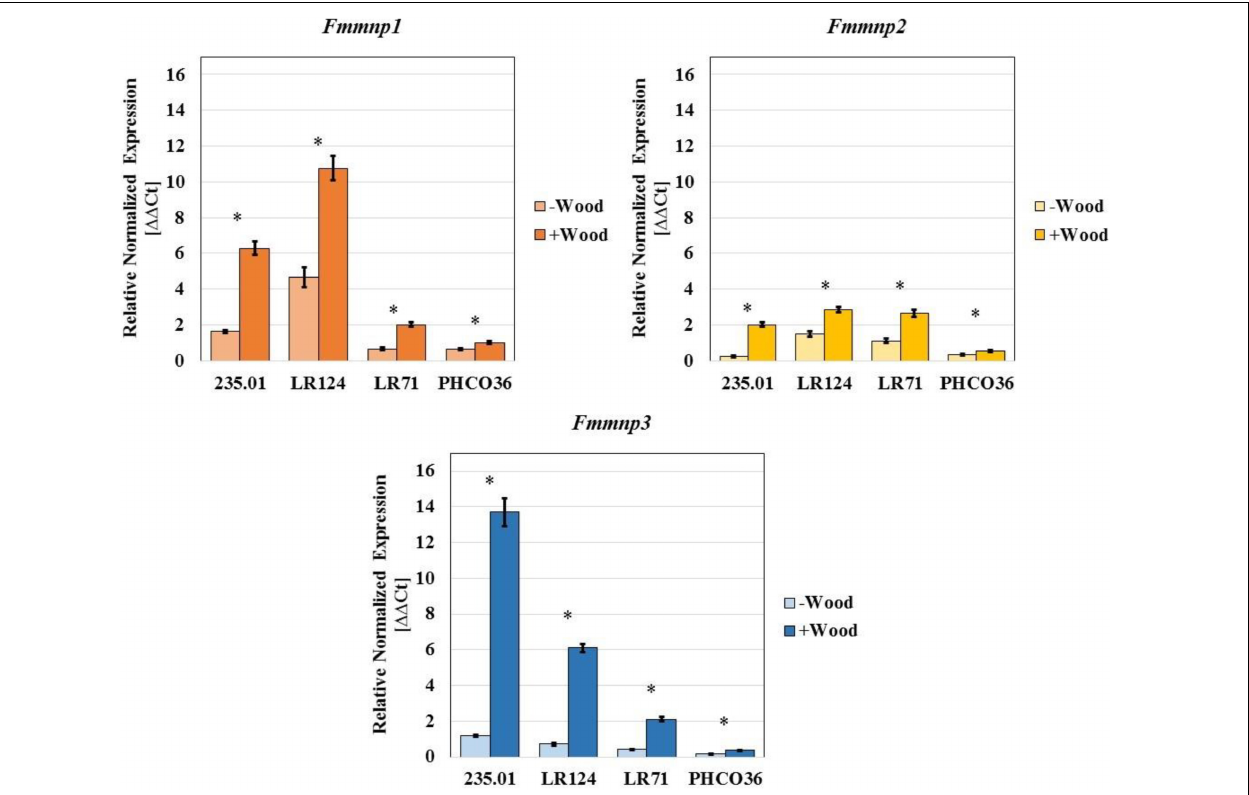
FIGURE 10 | Gene expression of three manganese peroxidase isoforms measured in 4 different strains of Fmed. Data are expressed as relative normalized expression of genes with cv. Gewurztraminer wood sawdust (+ Wood) and without sawdust (–Wood) compared to the mean of (cid:49) CT of samples grown without wood sawdust. The asterisk denotes significant difference in Student’s t -test with p ≤ 0.05 between gene expression with and without wood sawdust. Error bars on histograms represent the standard error of the